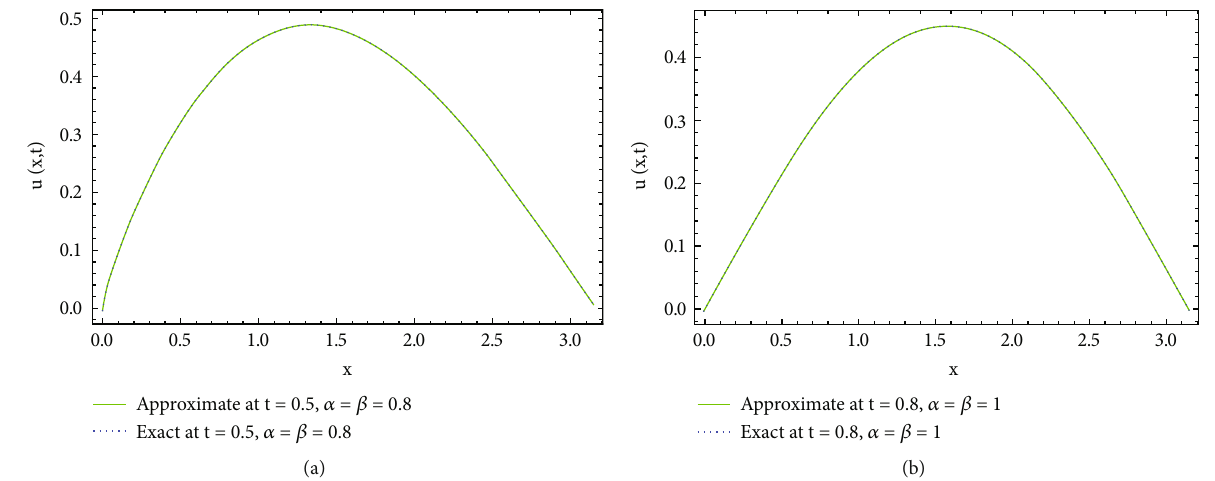
Figure 7: 2D solution plots of Example 3 obtained by the present method in comparison with the exact solutions for di ff erent values of fractional orders α and β